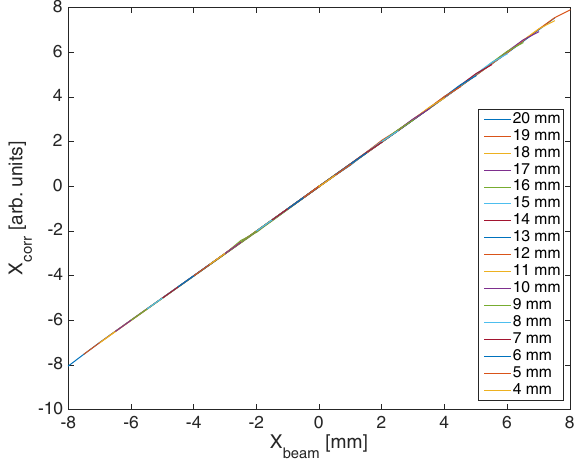
FIG. 14. The resulting corrected plot of X of X . beam